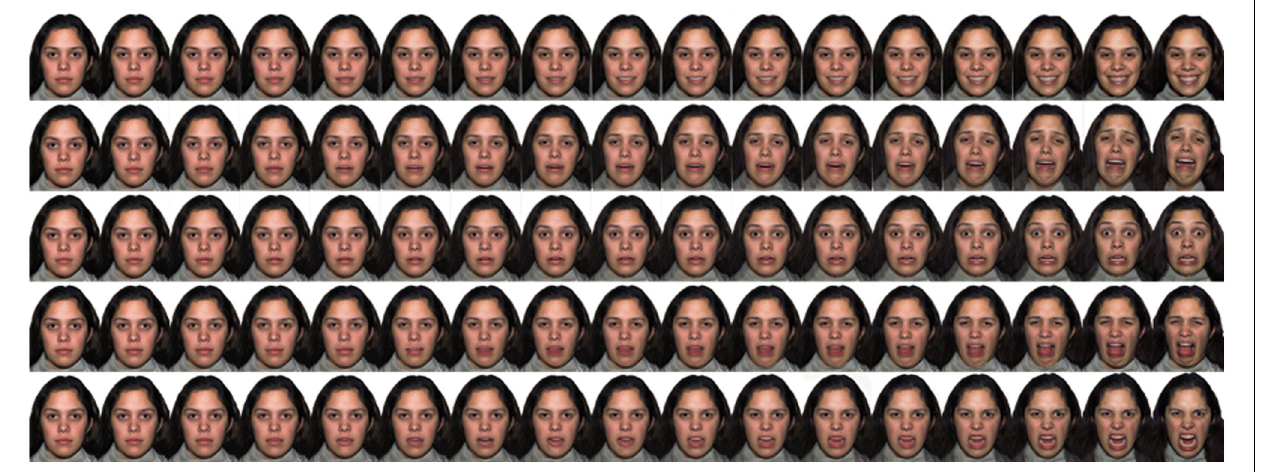
FIGURE 1 |A sample of facial expressions with varying intensity